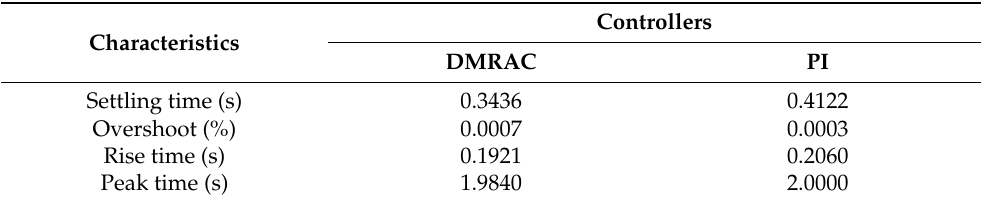
Table 4. Controllers’ characteristics for both DMRAC and PI